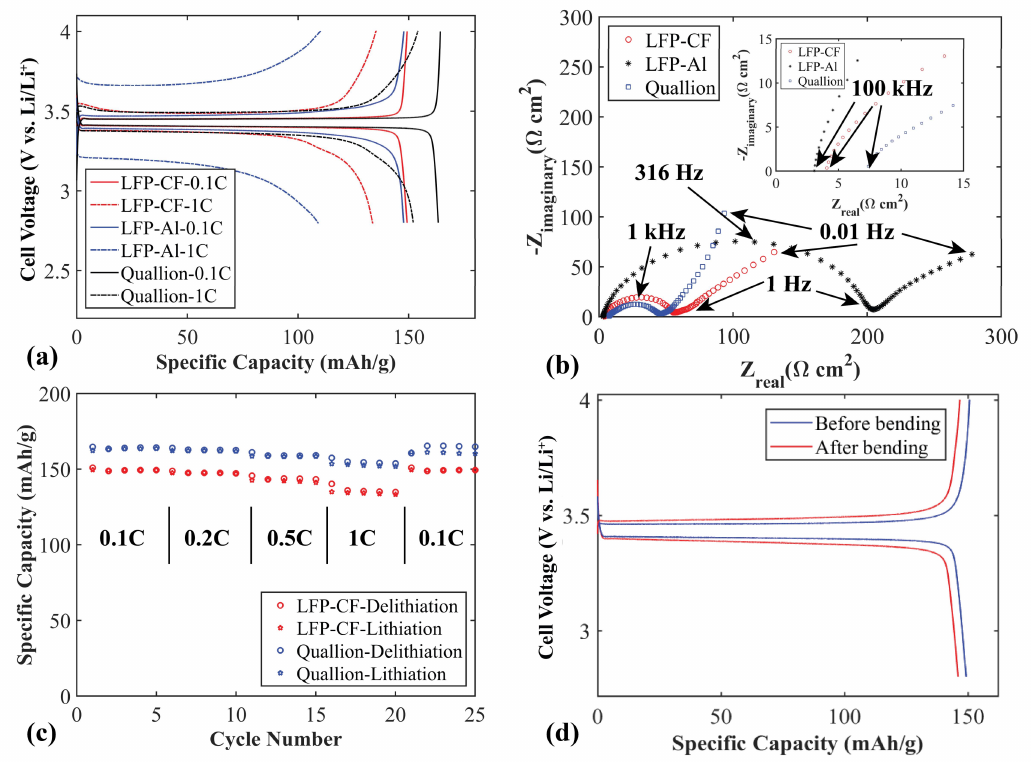
Figure 6. Electrochemical properties of electrodes: ( a ) charge/discharge voltage profiles of the LFP-CF, LFP-Al and Quallion electrodes cycled at 0.1 C and 1 C; ( b ) EIS of the LFP-CF, LFP-Al and Quallion electrodes; ( c ) rate capabilities of the LFP-CF and Quallion electrodes; and ( d ) voltage profiles at 0.1 C before and after 4000 times of repeated